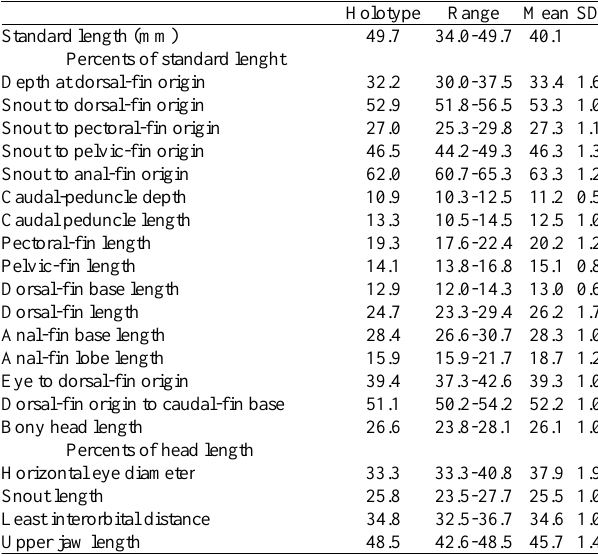
Table 2. Morphometric data of Moenkhausia plumbea . N = 32, SD = standard